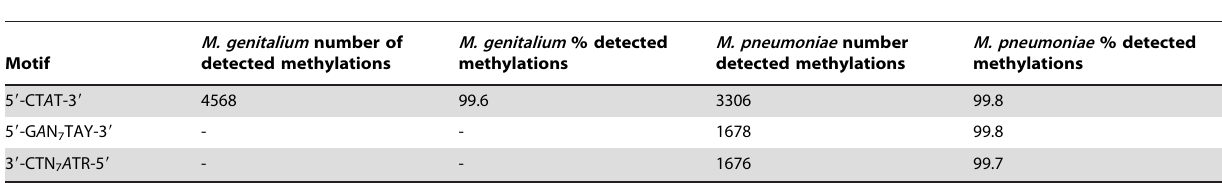
Table 2. Summary of discovered methylation motifs in M. genitalium and M.pneumoniae .